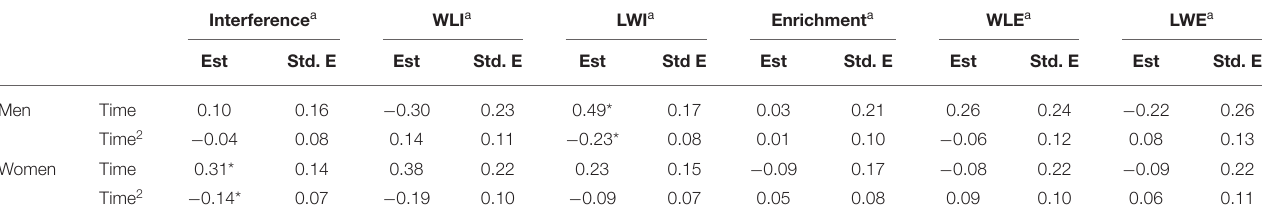
TABLE 5 | Quadratic growth curve for interference, WLI, LWI, enrichment, WLE, and LWE for men and women separately. Interference a WLI a LWI a Enrichment a WLE a LWE a Est Std. E Est Std. E Est Std E Est Std. E Est Std. E Std.